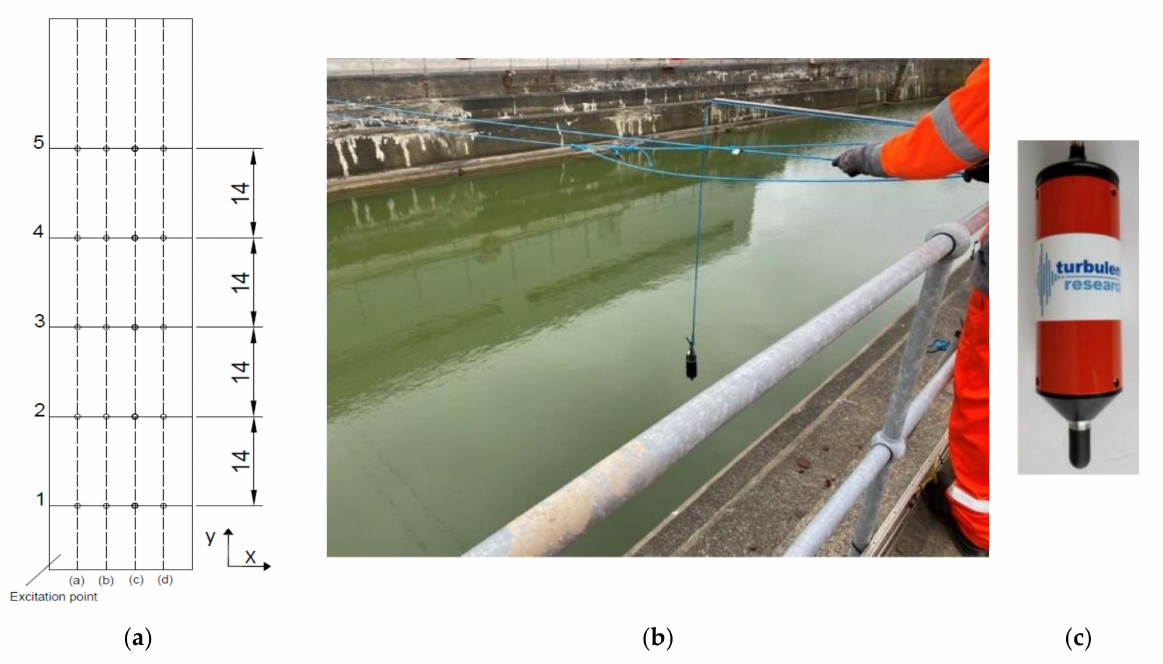
Figure 12. Measurement configuration, ( a ) the grid of measurement points ( b ) placing the hydrophone into the pool for the measurement and ( c ) the hydrophone type used to collect the pressure wave emitted at each stage—courtesy of Offshore Renewable Energy,